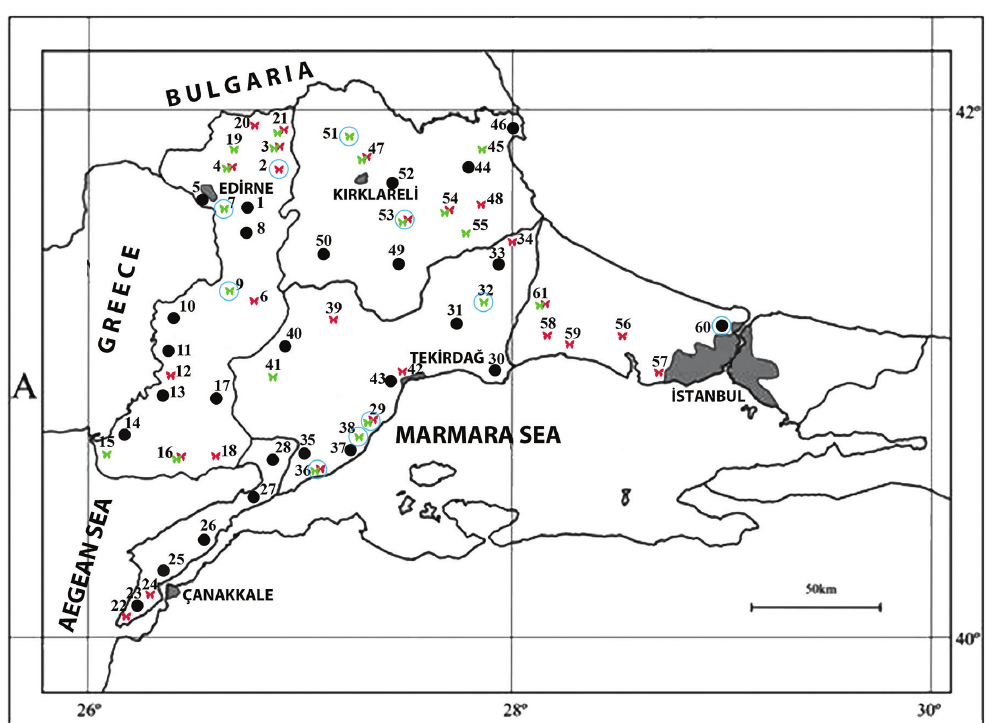
Figure 1. Map of the Thrace Region with studied localities. Moth symbols show sites where Zygaenidae were caught (green: Procridinae; red: Zygaeninae); black dots: sites where Zygaenidae were not found; blue circles: sites where traps with attractants were